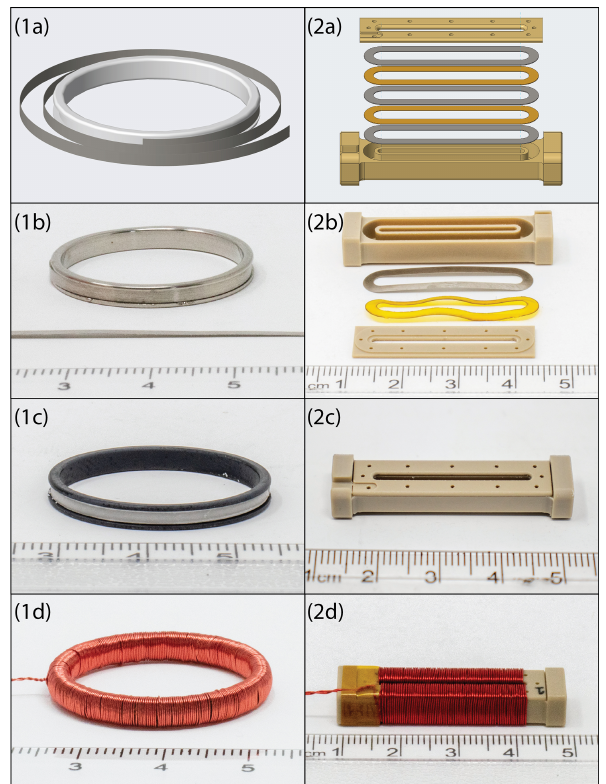
Figure 3. Assembly of a 1in. ring core illustrated by (1a) render of principle components, (1b) photo of main components, (1c) assem- bled ring core prior to application of drive winding, and (1d) wound ring core. Panels (2a) – (2d) show the same steps for the racetrack geometry